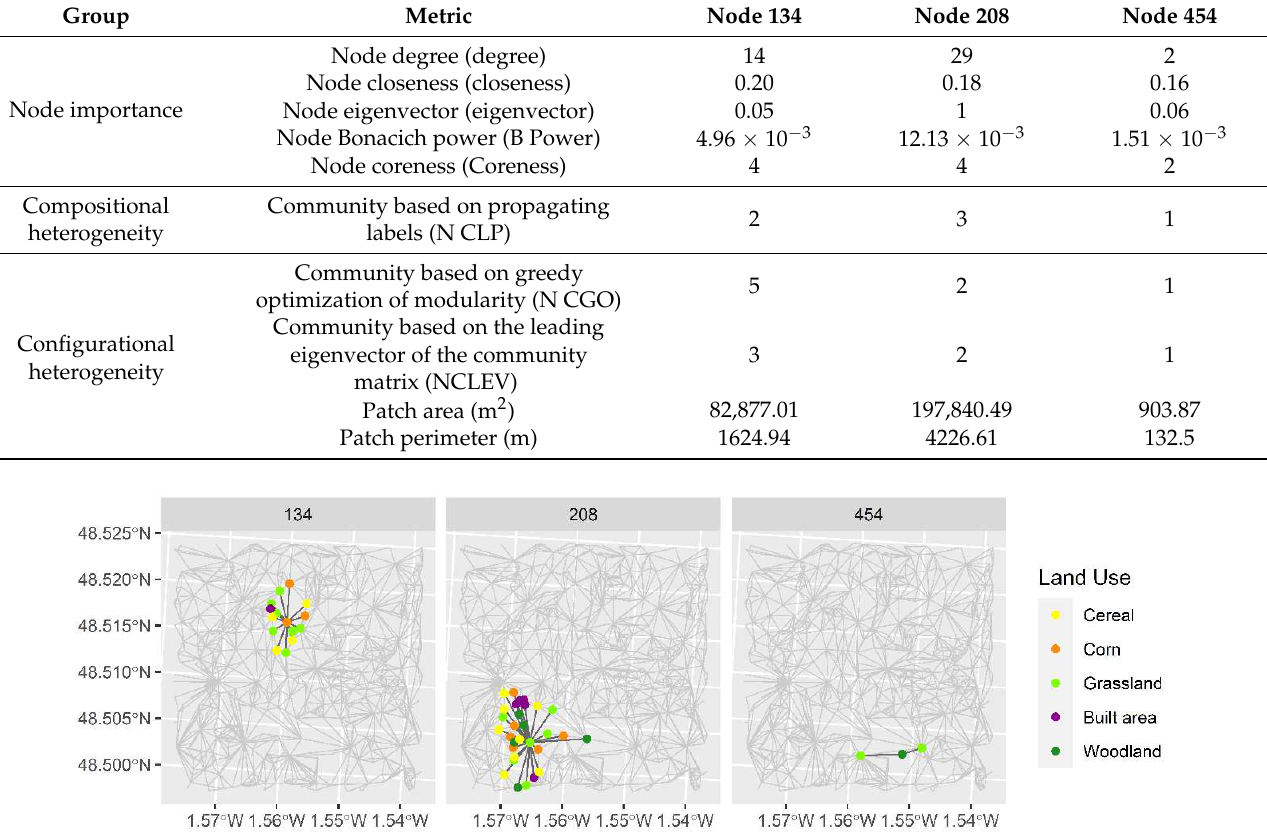
Figure 4. Graphs representing three contrasting nodes selected from landscape B in 2010. Different node colors represent different land uses in the patches. Differences are evident in the degree of each node, i.e., the number of paths of length one that emanate from the node.